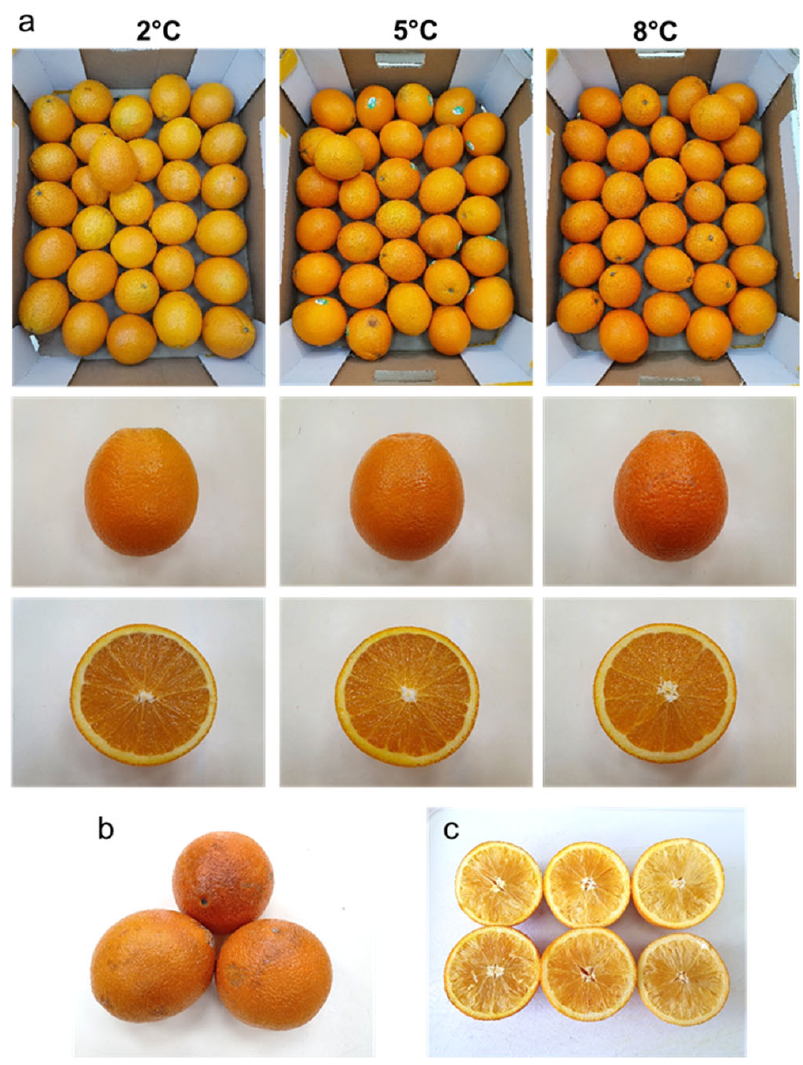
Figure 2. Photographs of ‘Rustenburg’ navel oranges. ( a ) Fruit stored at 2, 5 and 8°C, ( b ) chilling injury, and ( c ) internal dryness symptoms.